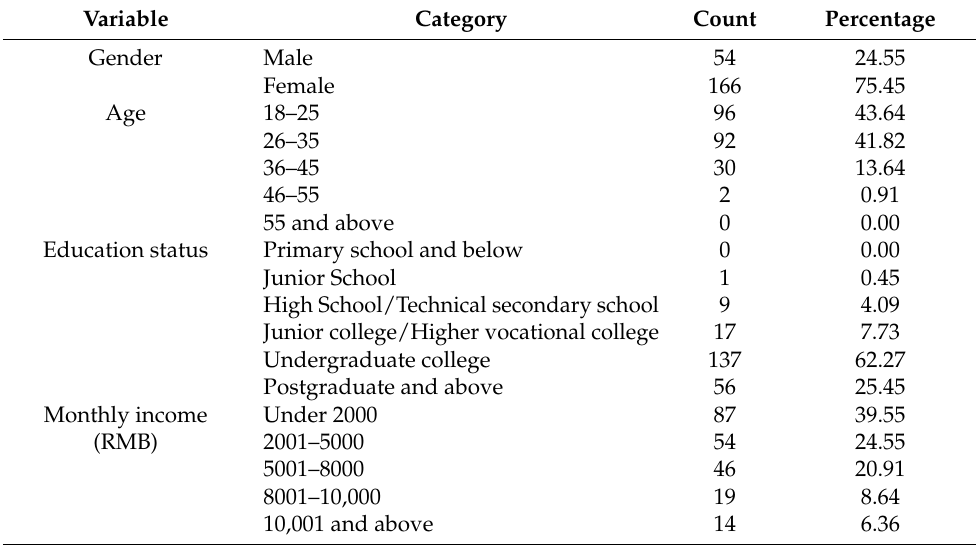
Table 2. Profile information of participants ( n = 220).